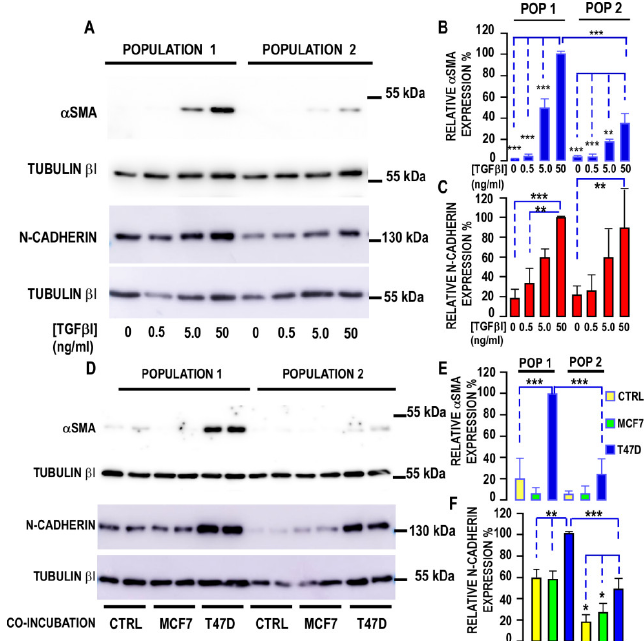
Figure 3. Myofibroblast differentiation of the two breast adipose progenitor cell (APC) populations. ( A ) Protein expression was measured in the two populations of breast APC submitted to increasing concentrations of TGF β for 3 days. Expressions of α SMA and N-cadherin were measured by SDS– PAGE, using gels with distinct percentage of acrylamide: 10% and 7.5% for α SMA and N-cadherin, respectively. Tubulin- β I was used as a loading control in both cases. Expressions of the two